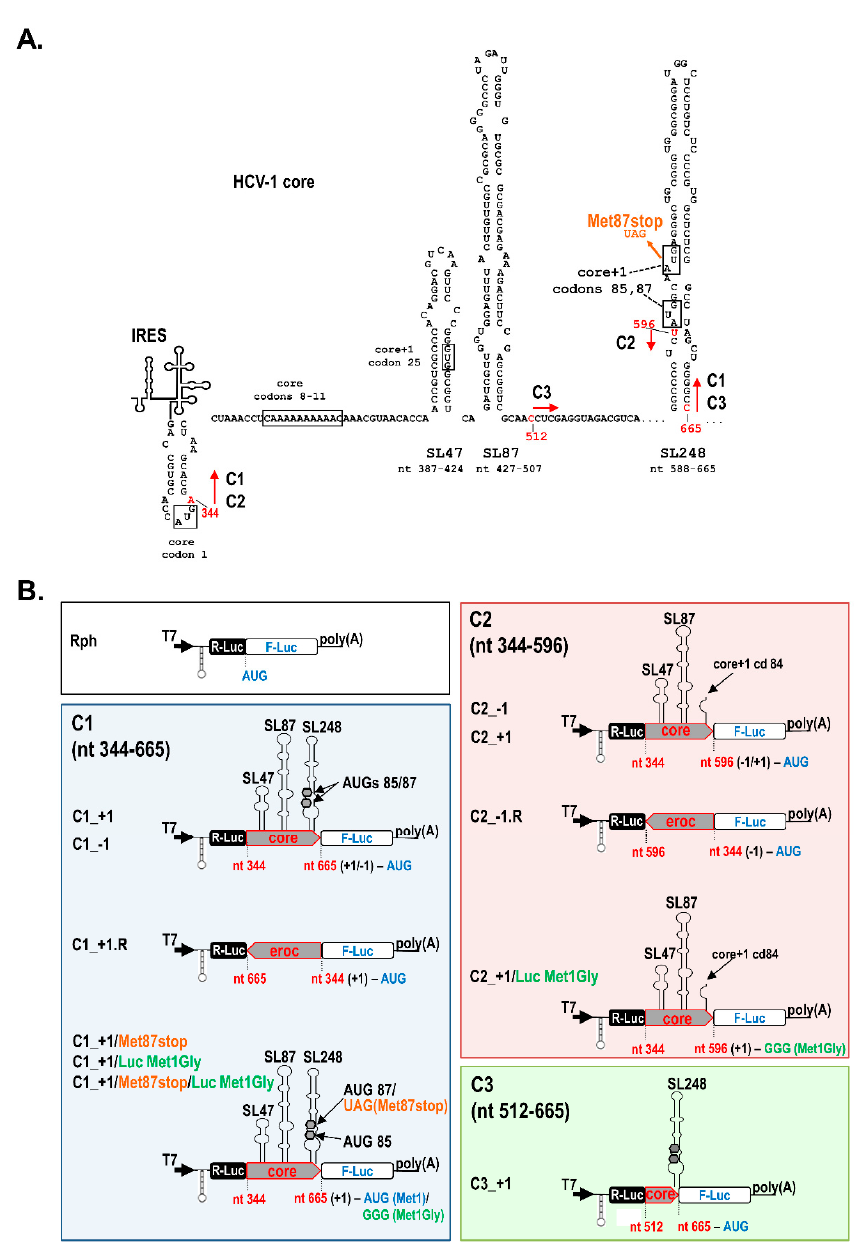
Figure 1. Schematic representation of the bicistronic plasmids constructed to investigate the mechanism directing core + 1 / Short (core + 1 / S) expression. ( A ) Scheme of HCV-1 (Hepatitis C virus) core coding region, including arrows indicating the start and end positions of the sequences (C1, C2, C3) inserted in the dual luciferase plasmids, relative to the predicted RNA secondary structures SL47, SL87, and SL248. ( B ) Diagram of the bicistronic constructs used. The parental vector is Renilla-photinus hairpin (Rph) ( B top left ), which has a stable hairpin (h) loop immediately upstream of the R-Luc gene and carries the Rph cassette under the control of a T7 promoter. Between the R-Luc and Firefly luciferase (F-Luc) genes, the parts of the HCV-1 core nucleotide sequence 344–665 (C1), 344–596 (C2), or 512–665 (C3) were cloned. Core sequences were inserted in the sense 5 (cid:48) -3 (cid:48) or reverse (R) 3 (cid:48) -5 (cid:48) orientation, and F-Luc gene was fused in the core + 1 or core − 1 frame. The Met87stop non-sense mutation at core + 1 frame codon 87 (panels a, b for C1 construct) and Luc Met1Gly double substitution converting the F-Luc initiation codon ATG to glycine codon GGG (panel b for C1 and C2 constructs) are also